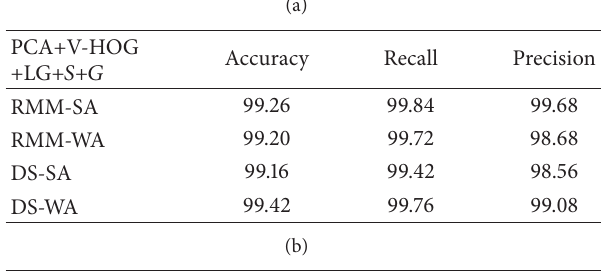
Table 7: Performance of the proposed ensembles for the front close/middle region. 𝐷 𝑗 wrong